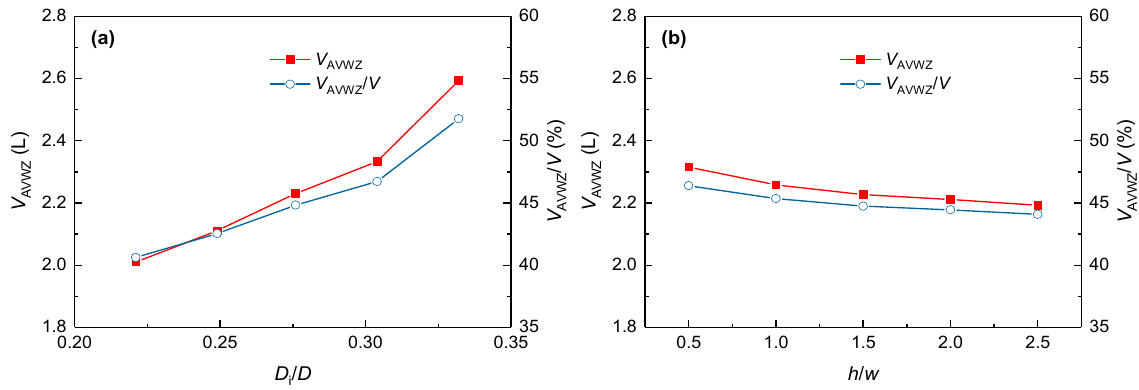
Figure 12. Effects of inlet structure on the AVWZ volume. ( a )-D i /D; ( b )-h/w.